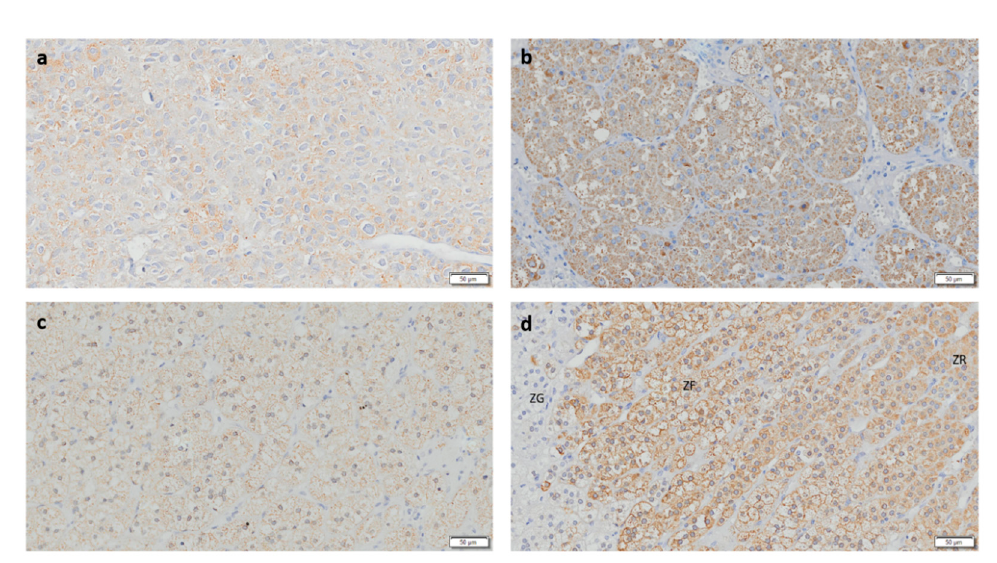
Figure 5. Immunohistochemistry staining for 17 α -hydroxylase (CYP17A1) (Scale = 50 μ m). ( a ) Adrenocortical carcinoma, ( b ) adrenocortical adenoma with Cushing’s Syndrome, ( c ) non-functioning adrenocortical adenoma, and ( d ) normal adrenal gland. ZG—zona glomerulosa; ZF—zona fasciculata; ZR—Zona